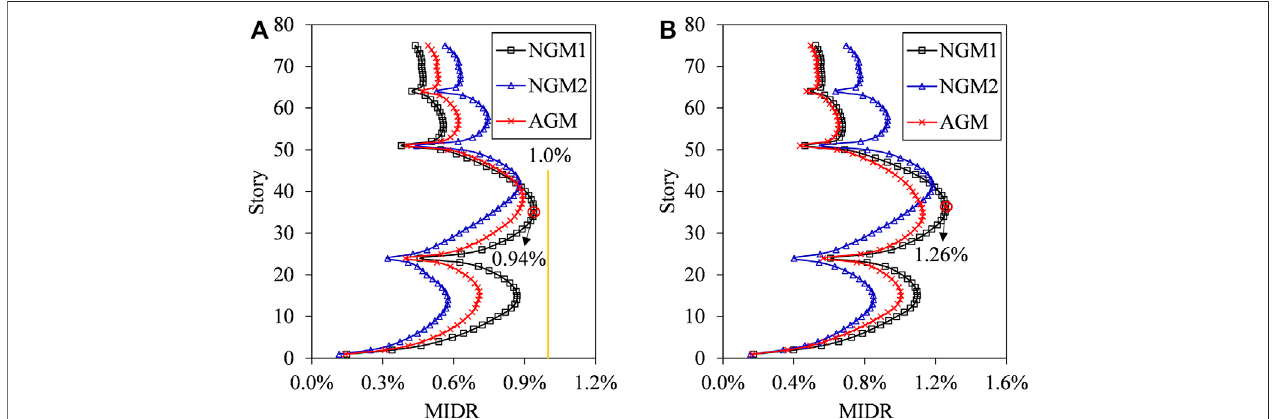
FIGURE 6 | Distribution of MIDR. (A) MIDR under PGA = 400 cm/s 2 . (B) MIDR under PGA = 510 cm/s 2 .